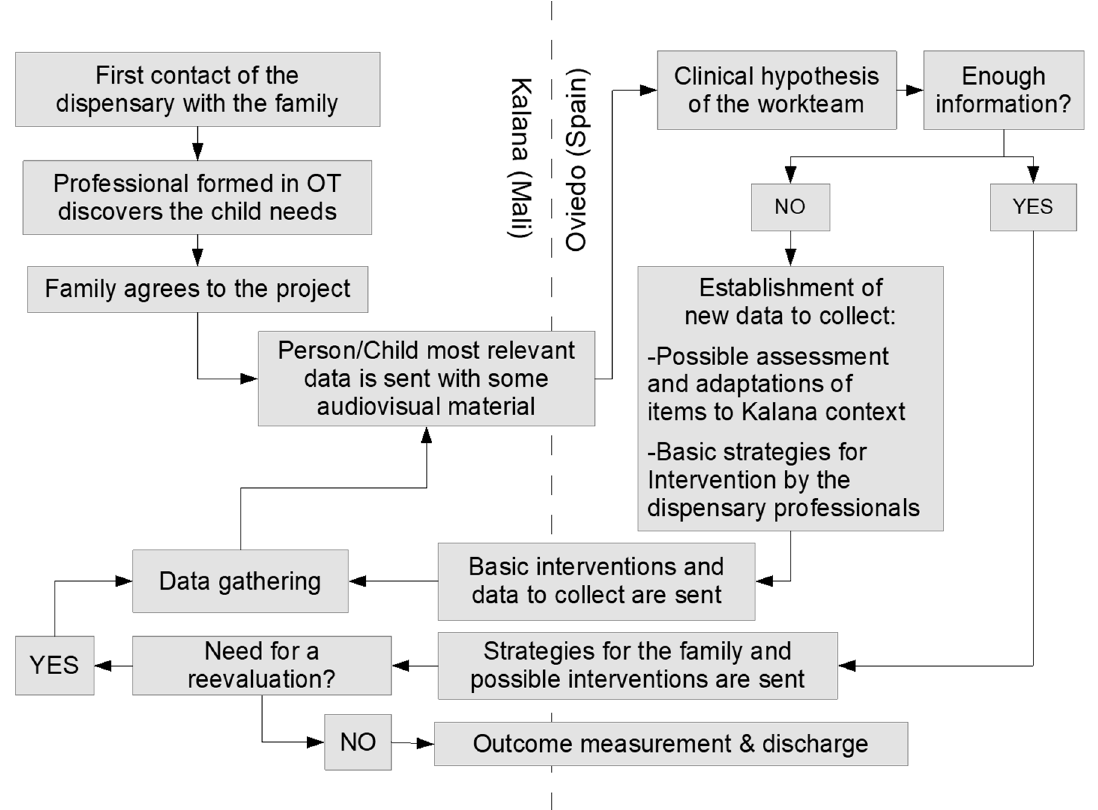
Figure 2. Data collection protocol.